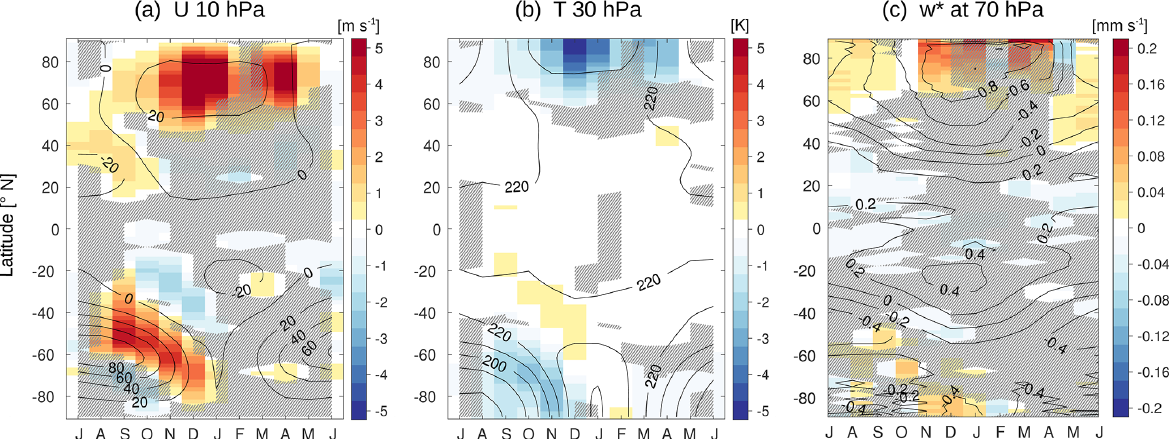
Figure 2. Climatological zonal mean (a) zonal wind at 10hPa in ms − 1 , (b) temperature at 30hPa in K, and (c) w ∗ at 70hPa in mms − 1 with month and latitude for Chem OFF (contours) and for the difference between Chem ON and Chem OFF (shading). Contour intervals are